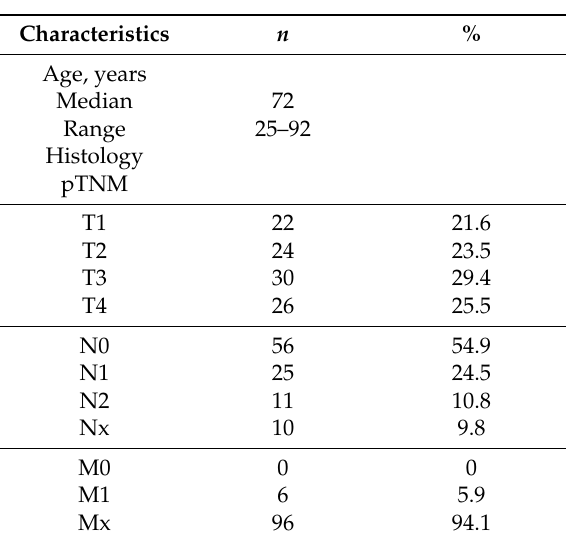
Table 1. Characteristics of CRC patients cohort ( n =